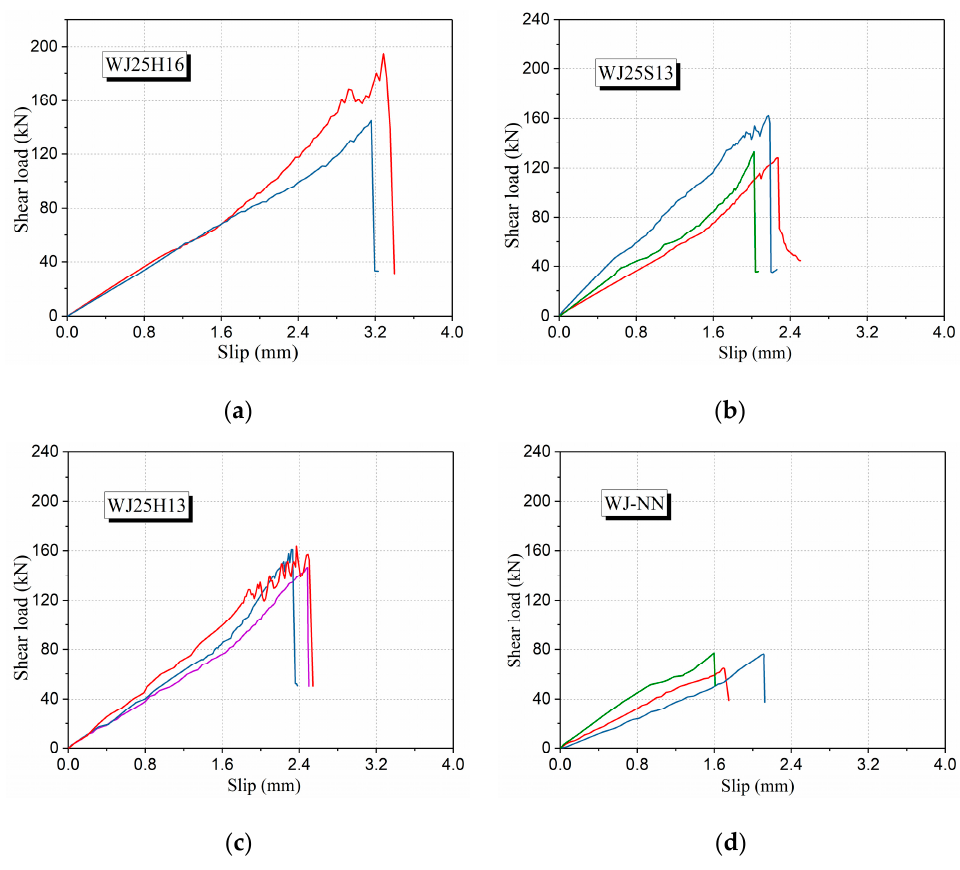
Figure 14. Shear load–slip curves of UHPC specimens with different fiber types: ( a ) WJ25H16, ( b ) WJ25S13, ( c ) WJ25H13 and ( d ) WJ-NN.